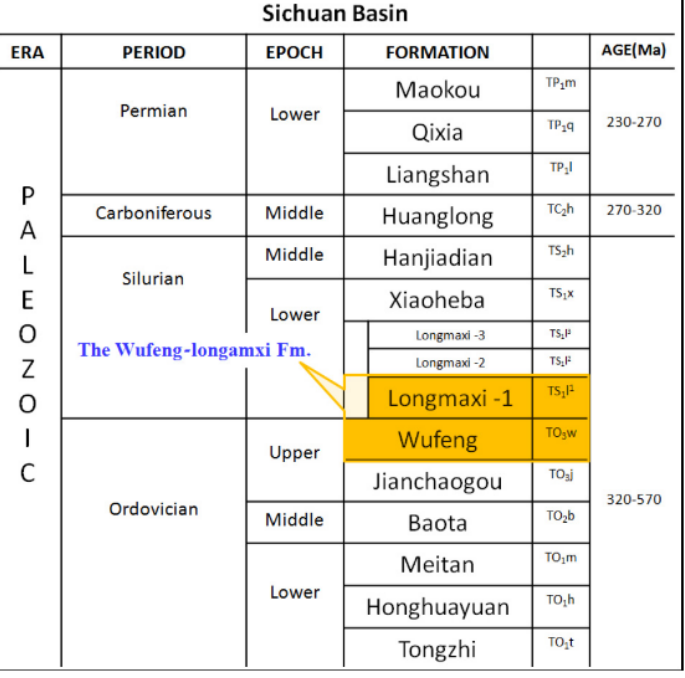
Figure 7. Stratigraphy of the Paleozoic of the Sichuan Basin, highlighting the Wufeng-Longmaxi Formation.